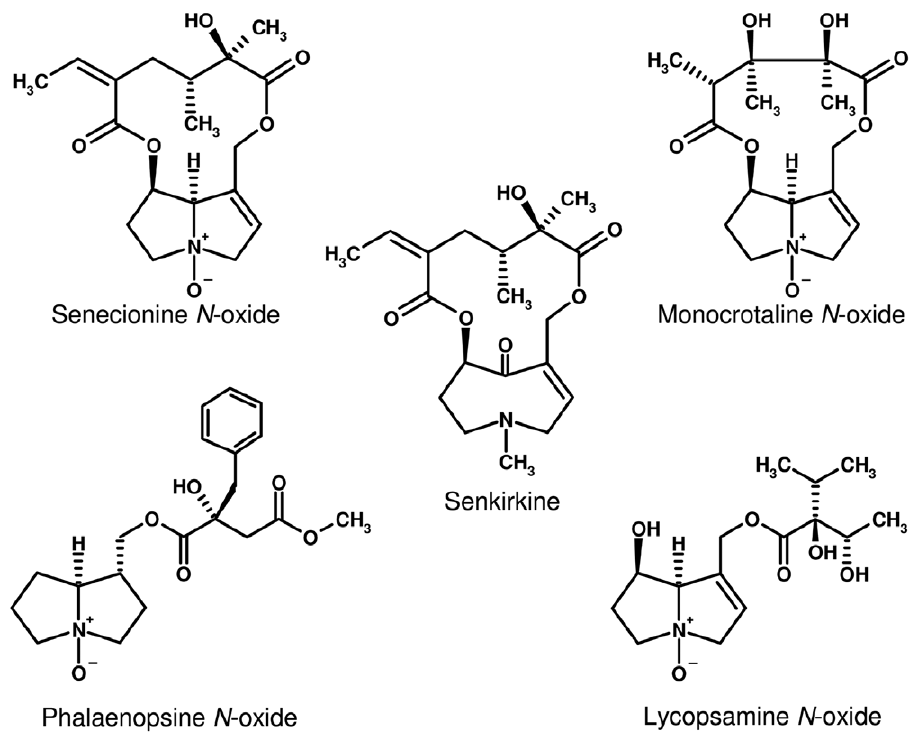
Figure 1. Structures of characteristic pyrrolizidine alkaloids. Structures are given in the N -oxide form with the exception of the otonecine derivative, senkirkine.